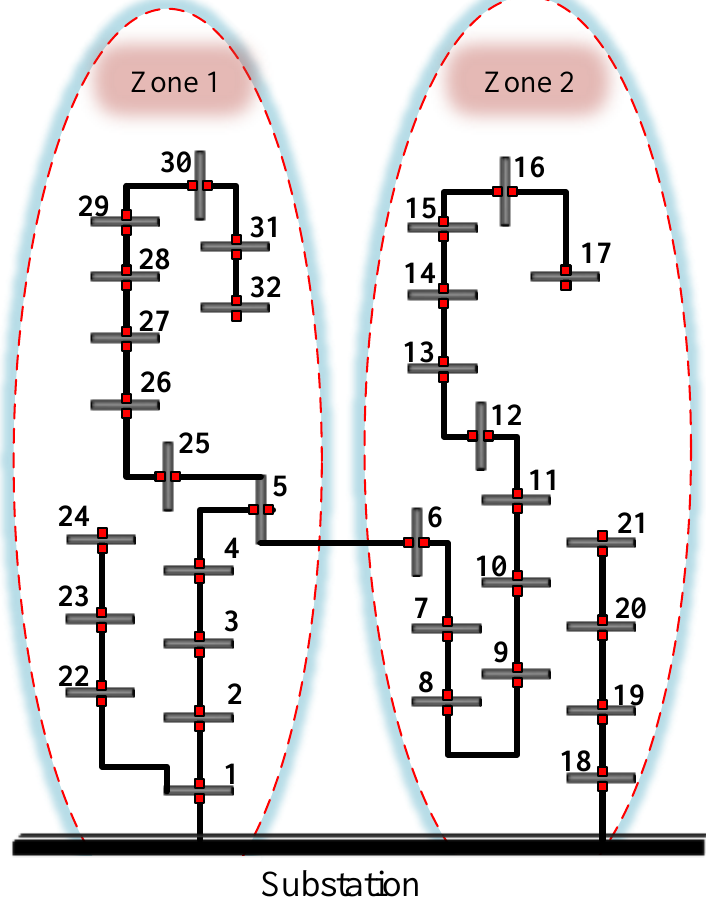
Figure 7. The single-line diagram of IEEE 32-bus grid.